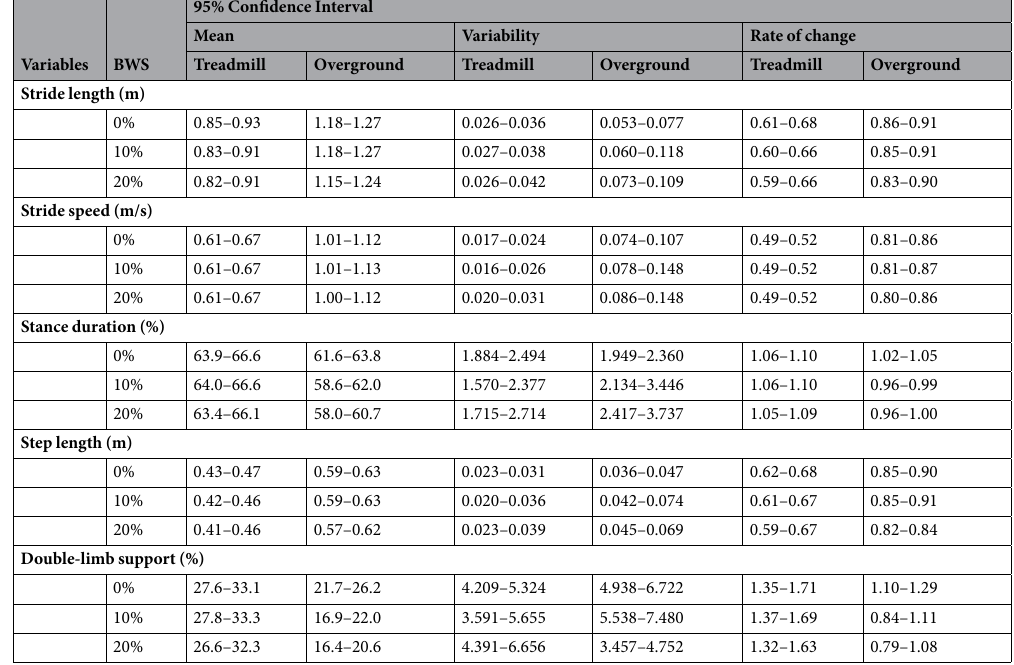
Table 1. The 95% confidence interval of the spatio-temporal gait parameters during 0%, 10%, and 20% of body weight support (BWS) on the treadmill and over the